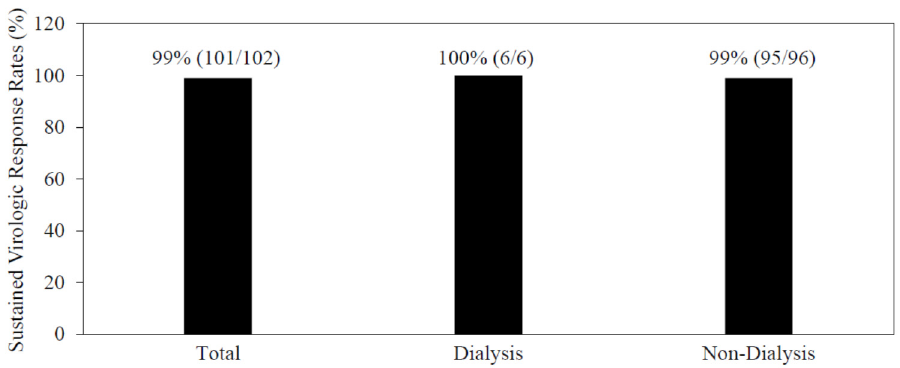
Figure 3. Higher sustained virologic response rates of combination treatment of glecaprevir/pibrentasvir for patients with or without dialysis in the present study. Table 3. Characteristics of six patients undergoing artificial dialysis with glecaprevir/pibrentasvir treatment.